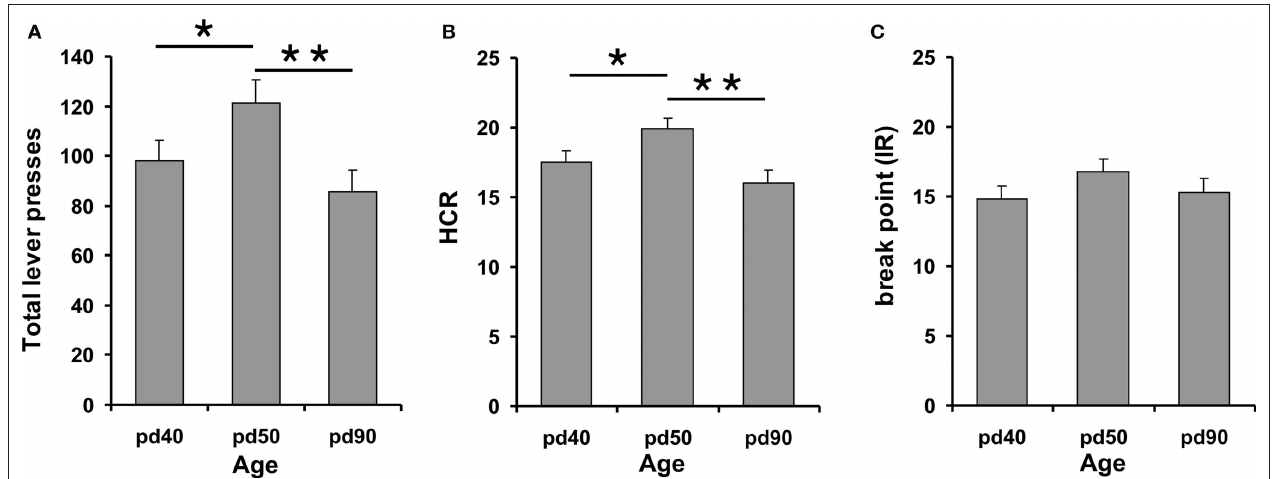
significantly from early-pubertal and adult animals for total lever presses and HCR. Asterisks (*) and (**) indicate significant differences at p -levels of p ≤ 0.05 and p ≤ 0.01, respectively. Data are expressed as mean ± SEM.